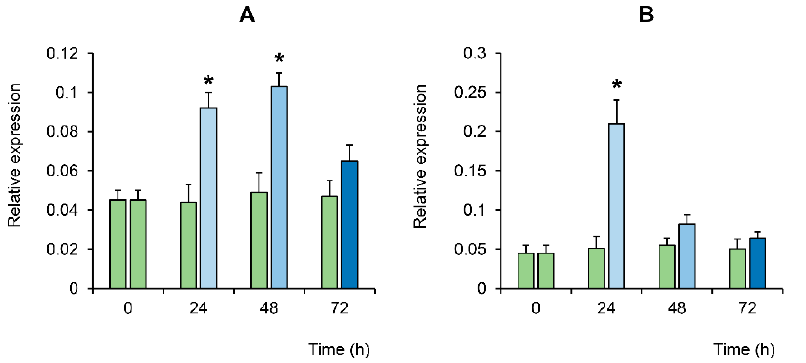
Figure 6. Changes in the relative expression of caspase 3 ( А ) and JNK ( B ) in the BMSC culture at different times after LTP exposure (relative to bAct, shown by the blue bars). The green bars indicate no exposure to plasma (i.e., the control). The values are given as means ± SEM ( n = 3). * p < 0.05 compared to the control.